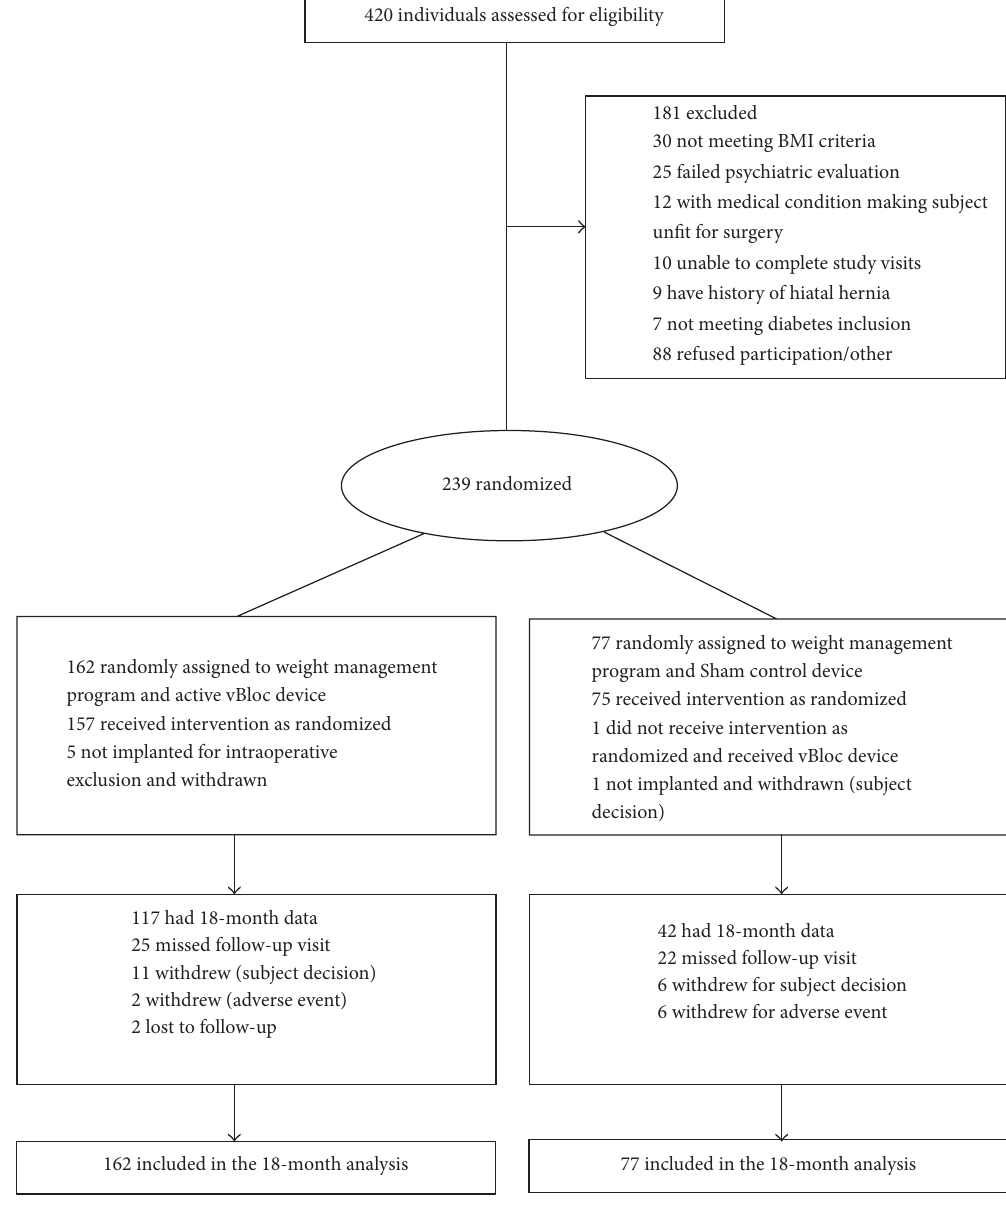
Figure 1: CONSORT diagram through 18